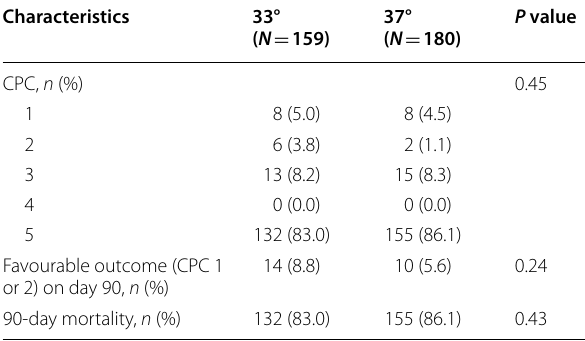
Table 2 Outcomes of patients with postresuscitation